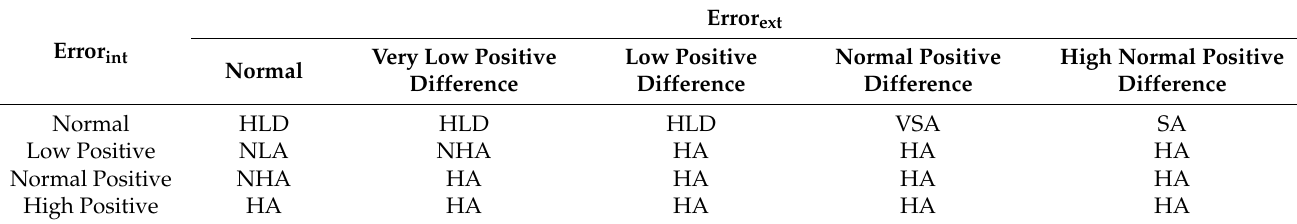
Table 2. Heating control